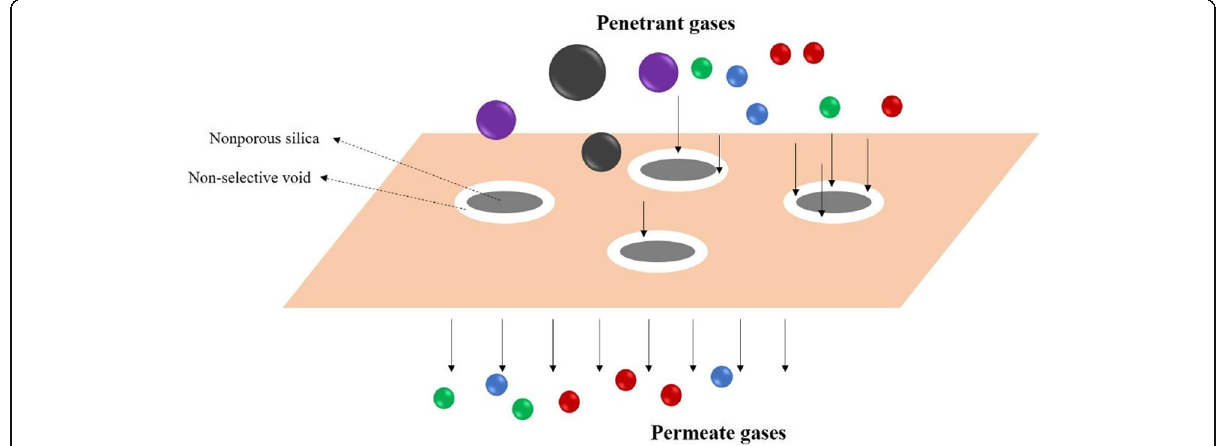
Fig. 6 Gas transport mechanism of penetrant gases through MMMs containing nonporous silica with non-selective